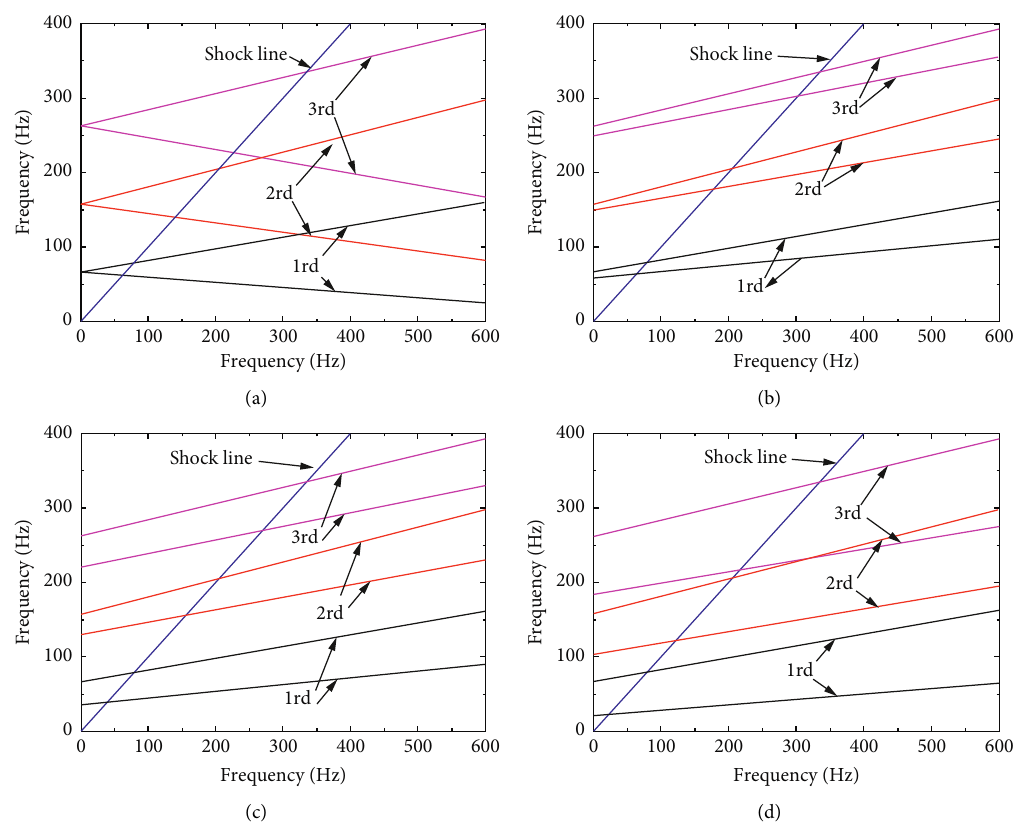
Figure 6: Campbell diagram of rod fastened rotor under nonuniform stiffness. (a) k